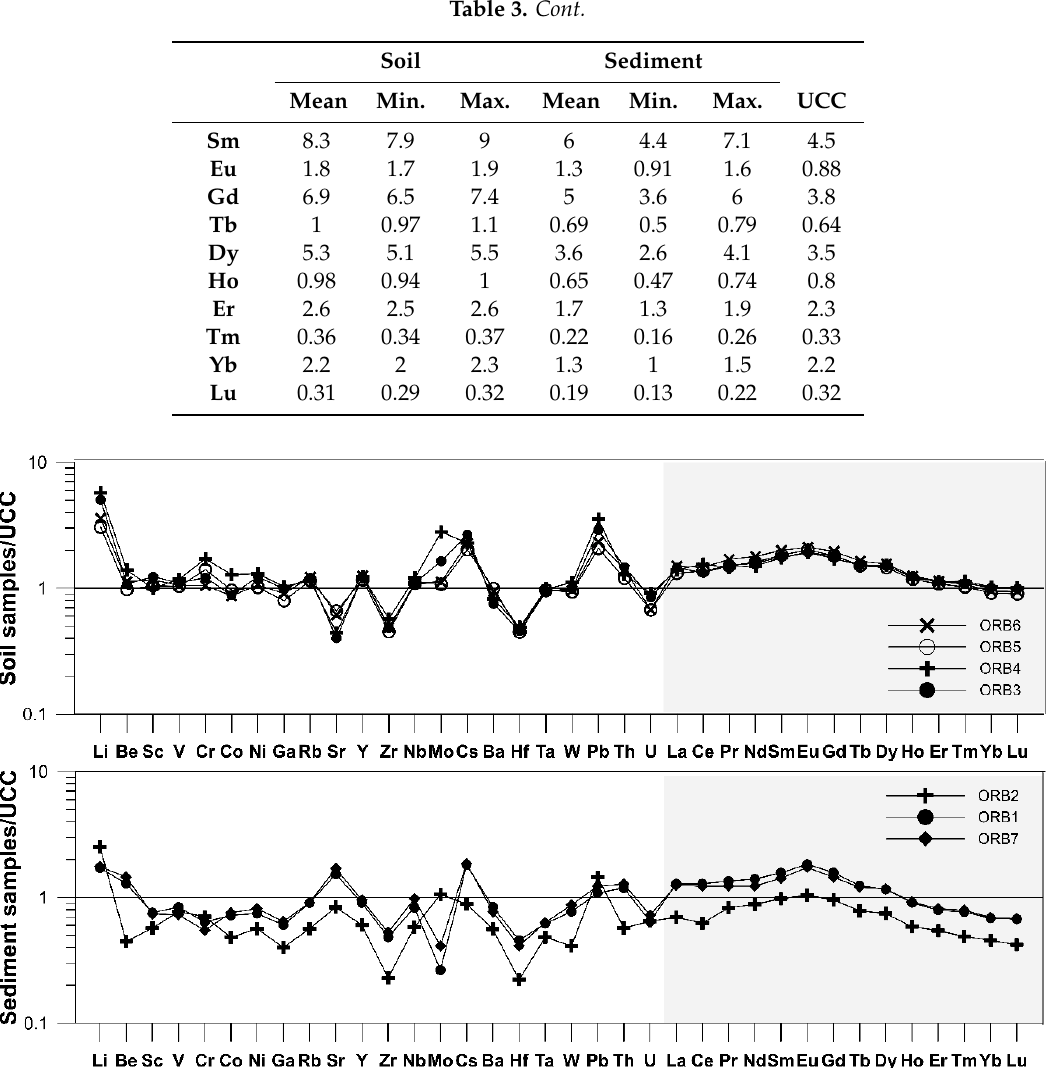
Figure 8. Trace element and REE (highlighted by gray shadow) abundance patterns normalized to UCC (McLennan, 2001) for soil and sediment samples. The Y -axis is logarithmic (Log base 10).